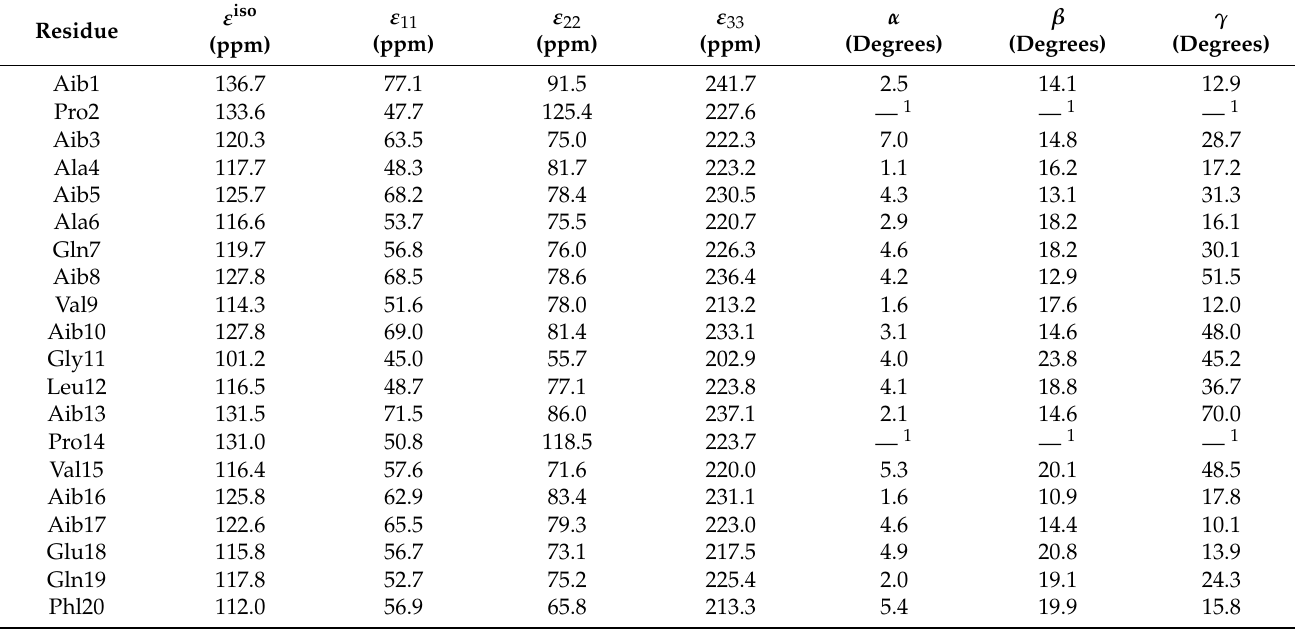
Table 2. Predicted values of the 15 N SSNMR parameters of amidic nitrogens in ALM-E18 model.